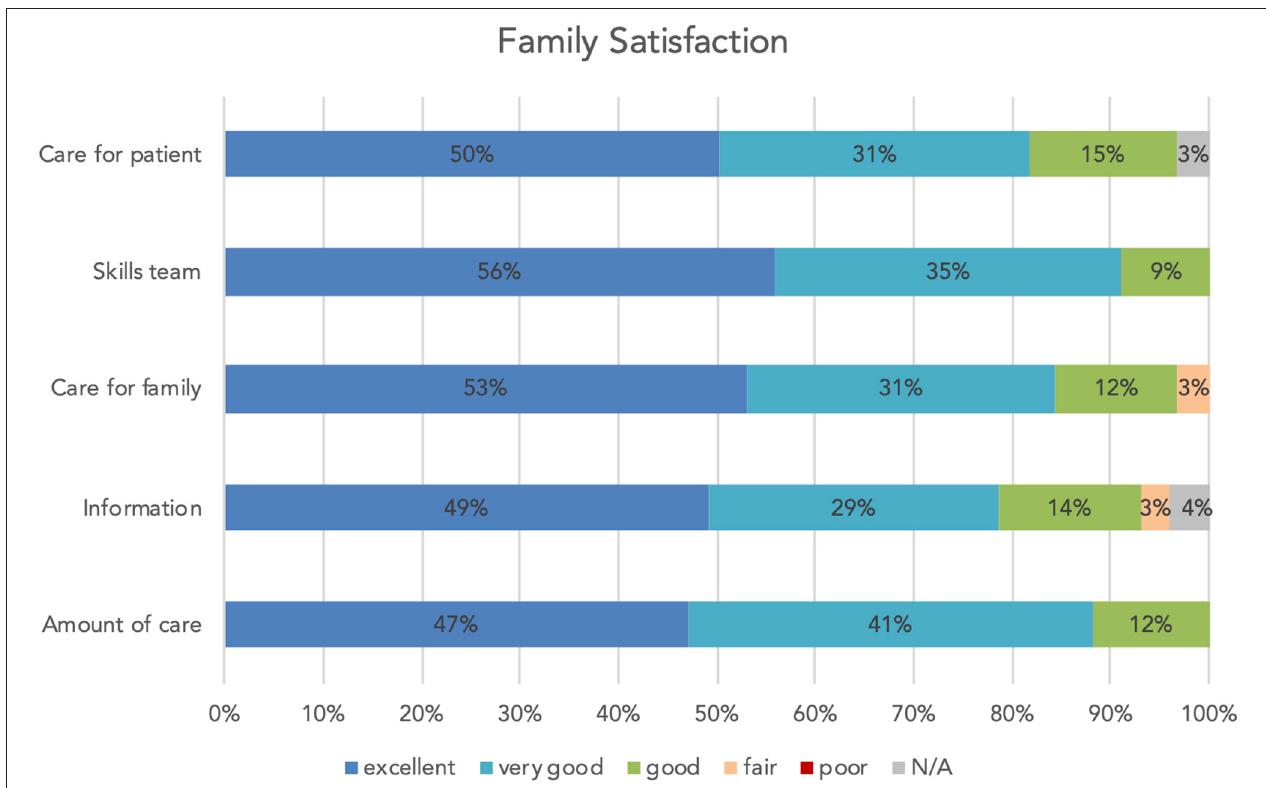
FIGURE 1 | Family satisfaction: care for the patient (concern and caring, management of pain, breathlessness and agitation), skills team (physicians and nurses), care for family (consideration of needs, emotional support, coordination of care, concern and caring), information (frequency, ease of getting, understanding, honesty, completeness and consistency), amount/level of care patient received.